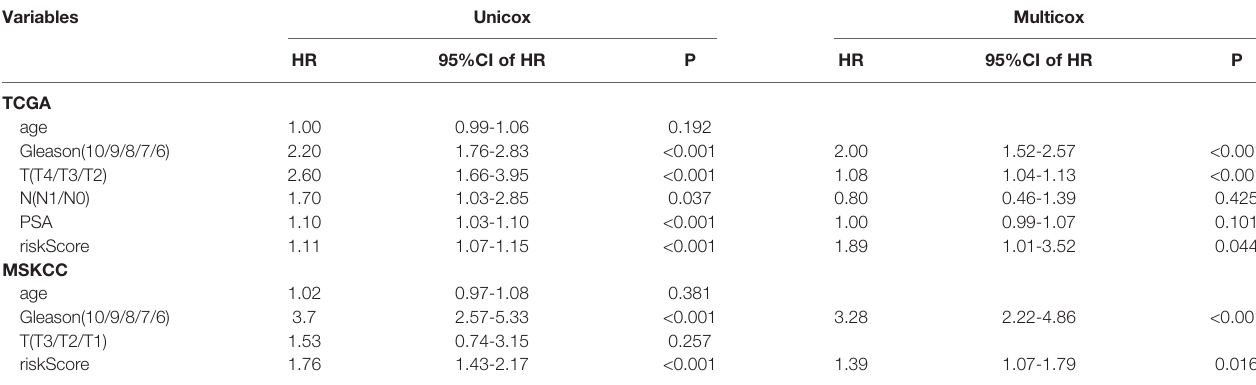
TABLE 2 | Univariate Cox regression and multivariate Cox regression analysis of riskScore and clinical information in TCGA and MSKCC cohorts.